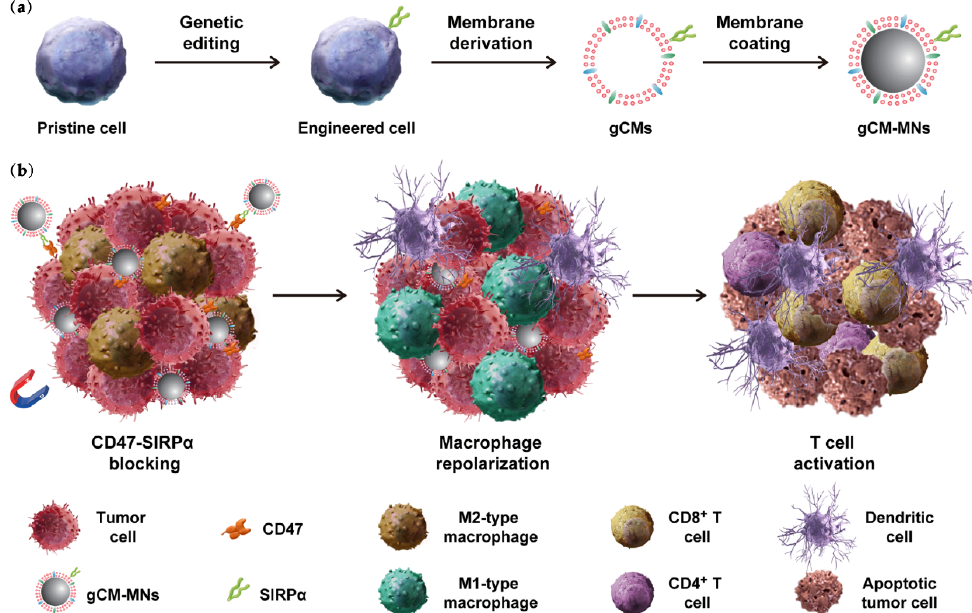
Figure 9. Scheme of genetically edited cell membrane-coated magnetic nanoparticles (gCM-MNs) elicit potent macrophage immune responses for cancer immunotherapy. ( a ) Cell membranes were isolated from the genetically engineered cells, overexpressing SIRP α variants and then coated onto magnetic nanoparticles (MNs); ( b ) under external magnetic field, gCM-MNs efficiently accumulate in the tumor microenvironment, block the CD47-SIRP α “don’t eat me” pathway, and repolarize TAMs towards M1 phenotype, promoting macrophage phagocytosis of cancer cells as well as boosting antitumor T-cell immunity. Reprinted with permission from Ref. [28]. Copyright 2020 John Willey and